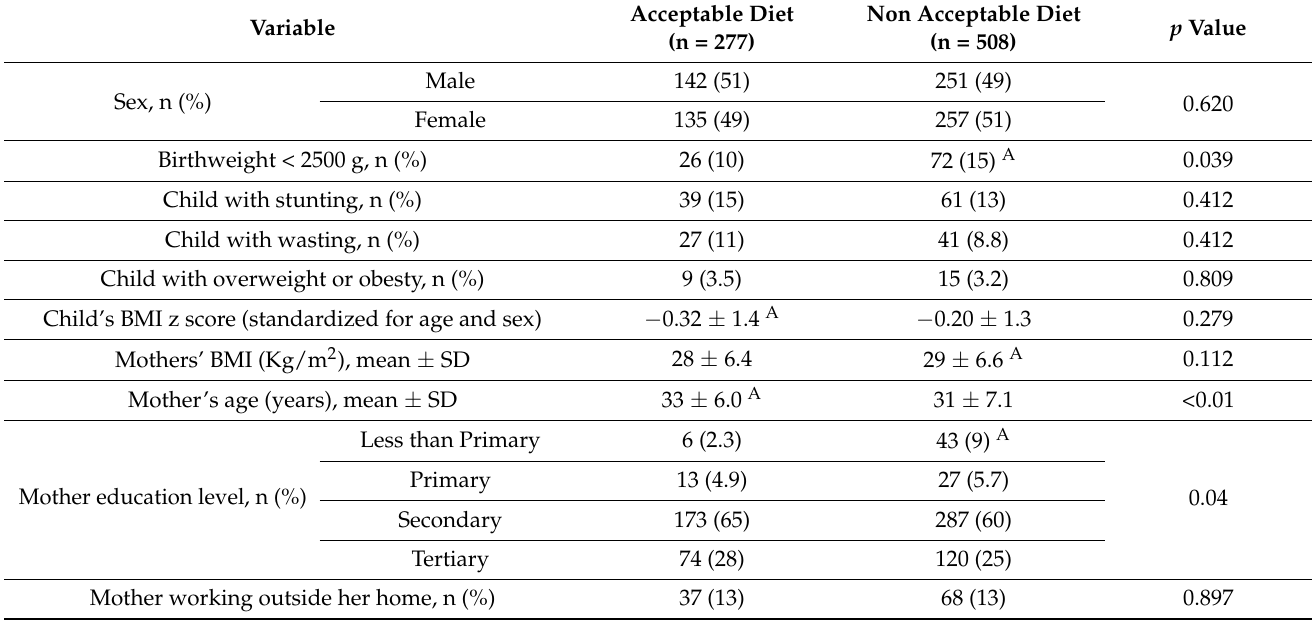
Table 3. Participants’ characteristics by acceptable diet